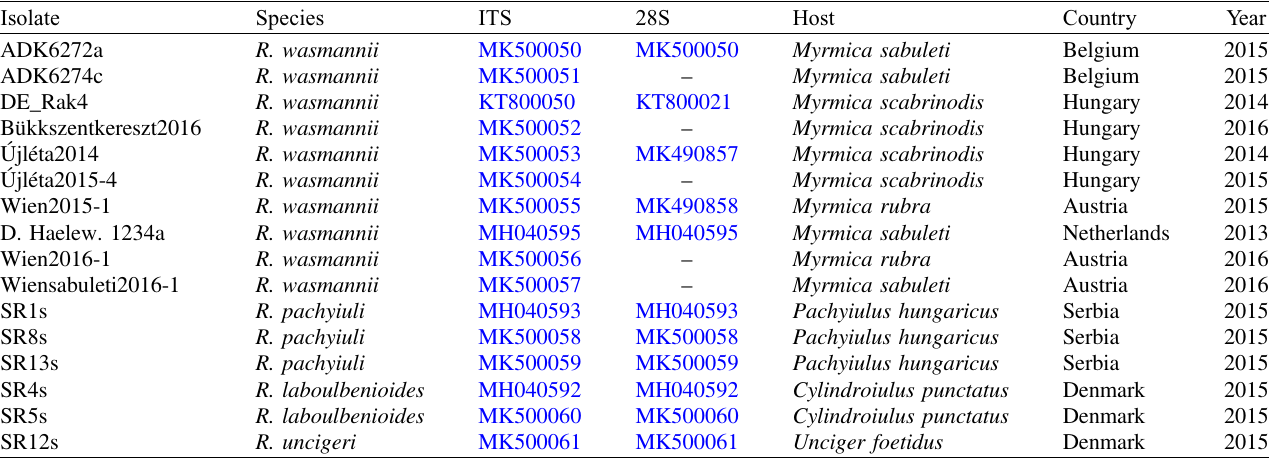
Table 1. Overview of Rickia sequences used in this study. All isolates for which sequences were generated are listed, with GenBank accession numbers as well as host species, country, and year of